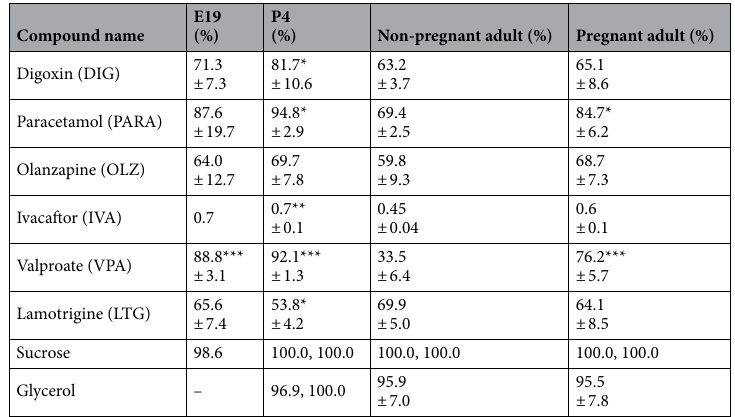
Table 3. Free fraction of drugs in plasma of E19, P4, non-pregnant and pregnant female adult rats. Protein- free fraction/whole plasma concentration ratios (%) in plasma of E19, P4, non-pregnant and pregnant female adult rats spiked with test compounds and their respective radiolabelled form. Mean ± SD where n = 3; where number of samples were < 3, individual values are listed. Asterisk represents values significantly different to that of non-pregnant adults by unpaired Student t tests with F tests, * p < 0.05, ** p < 0.01, *** p < 0.001.